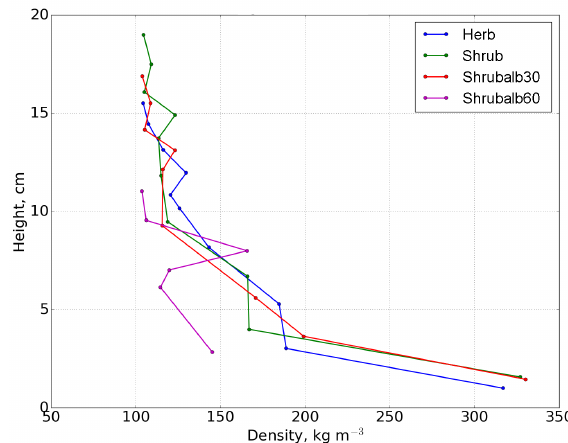
Figure 10. Vertical density profiles simulated by Crocus on 10 Oc- tober 2014, for the different scenarios. Densities shown are for the middle of the layers used by Crocus.